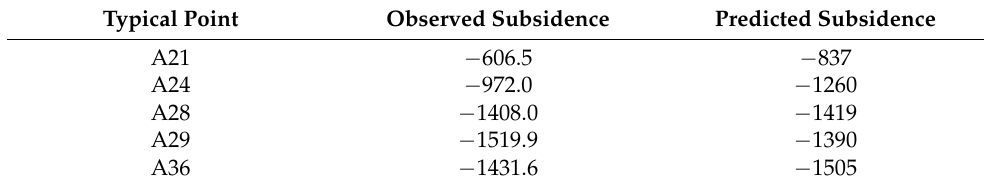
Table 4. The observed and predicted maximum subsidence values for the typical points (mm). Typical Point Observed